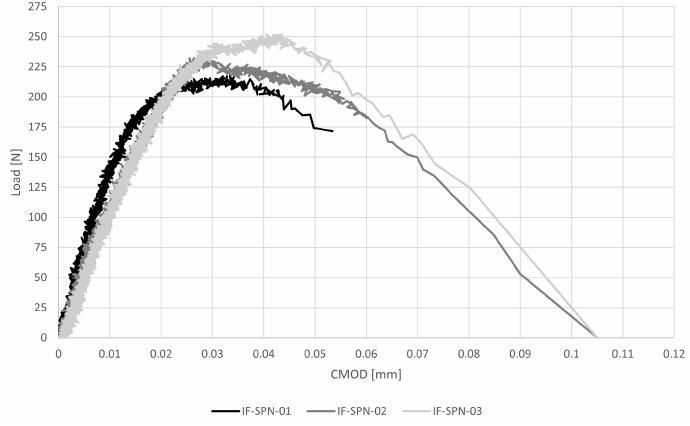
Figure 8. Load-crack mouth opening displacement response for mode- I fracture energy three-point bending tests (IF-SPN). Table 5. Results of mode-I fracture energy three-point bending tests (IF-SPN) in terms of maximum peak load P, corresponding flexural stress σ f according to the classical mono-modulus beam model, corresponding vertical displacement η , fracture energy G F and crack mouth opening displacement, CMOD.